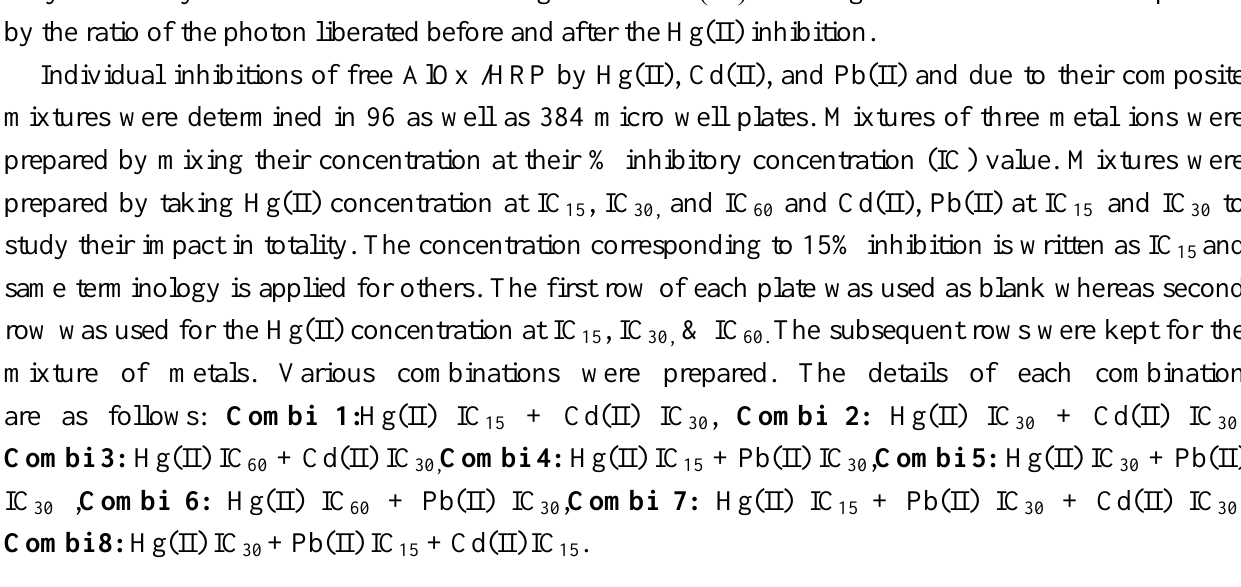
Scheme 2. Schematic representation of AlOx assay.